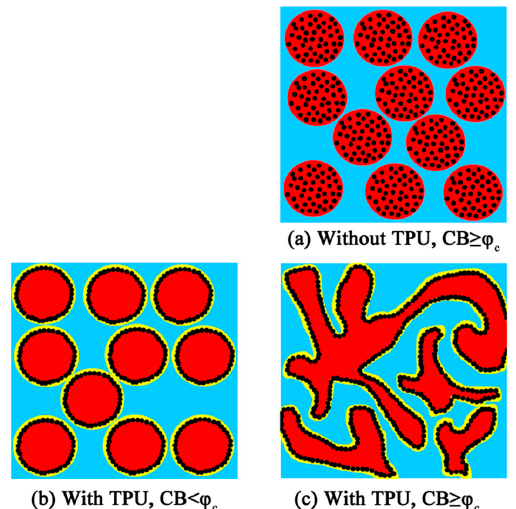
Figure 7. Schematic illustration for the conductive network formation in CB-filled POM/COPA/TPU ternary